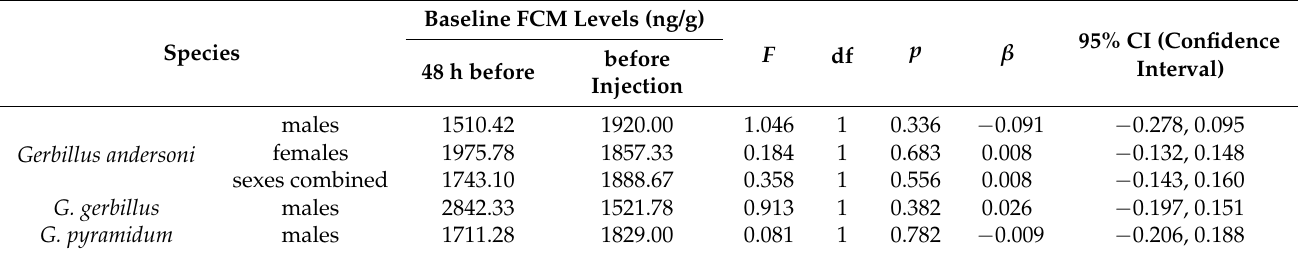
Table 1. Baseline fecal corticosterone metabolite (FCM) levels in the three gerbil species.